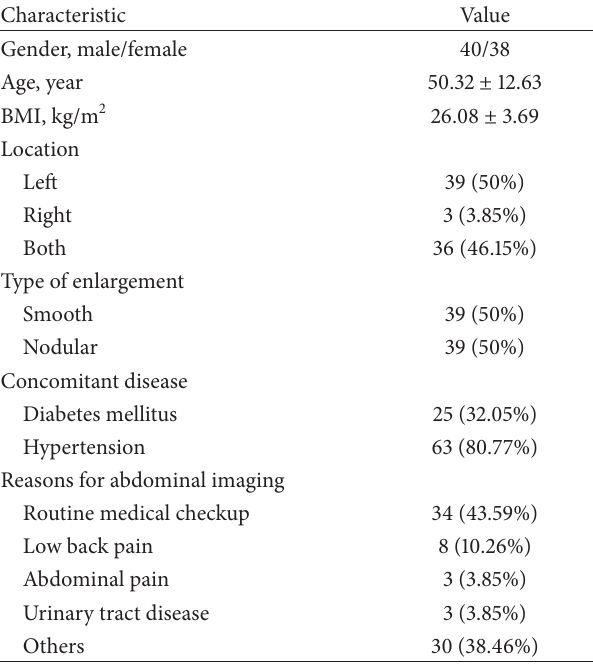
Figure 1: The distribution of cases along with the year. Table 1: Clinical characteristics of patients with incidental adrenal